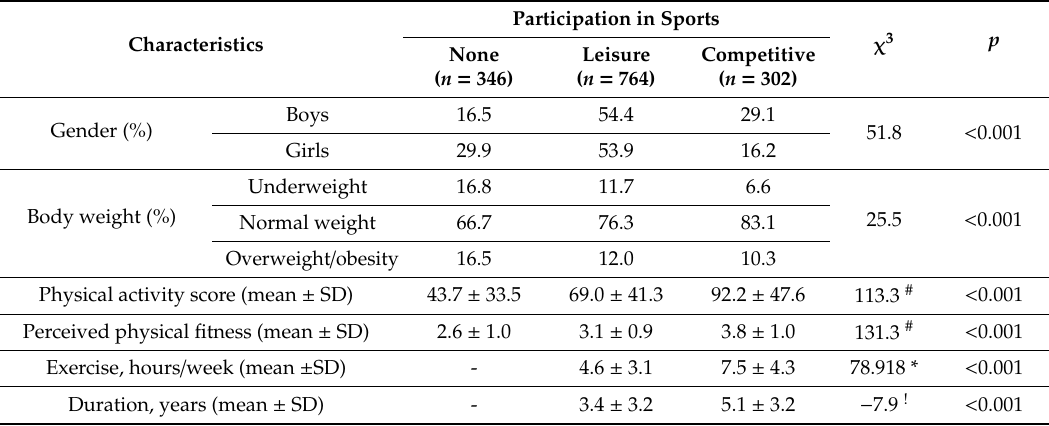
Table 1. Descriptive statistics of the adolescent sample in sports groups ( n =